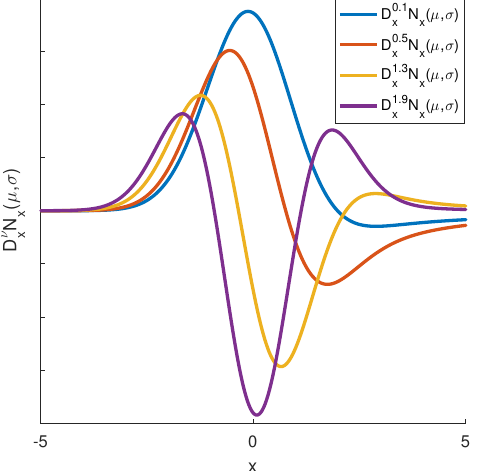
Figure 4. FOGF kernels using the base Gaussian function f ( x ) = N x ( 0.0,1.0 ) for the four fractional derivative orders ν ∈ { 0.1,0.4,1.3,1.9 } .